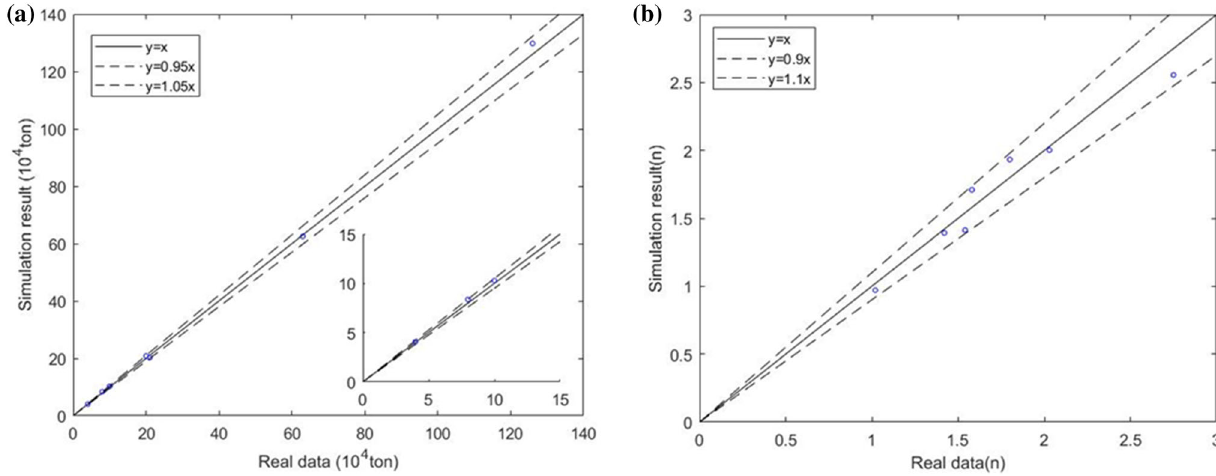
Fig. 5 Comparing simulation results with real data (left: facility throughputs; right: average counts of shipments) Table 3 Summarised results of efficiency, economic performance, and environmental impact Operational